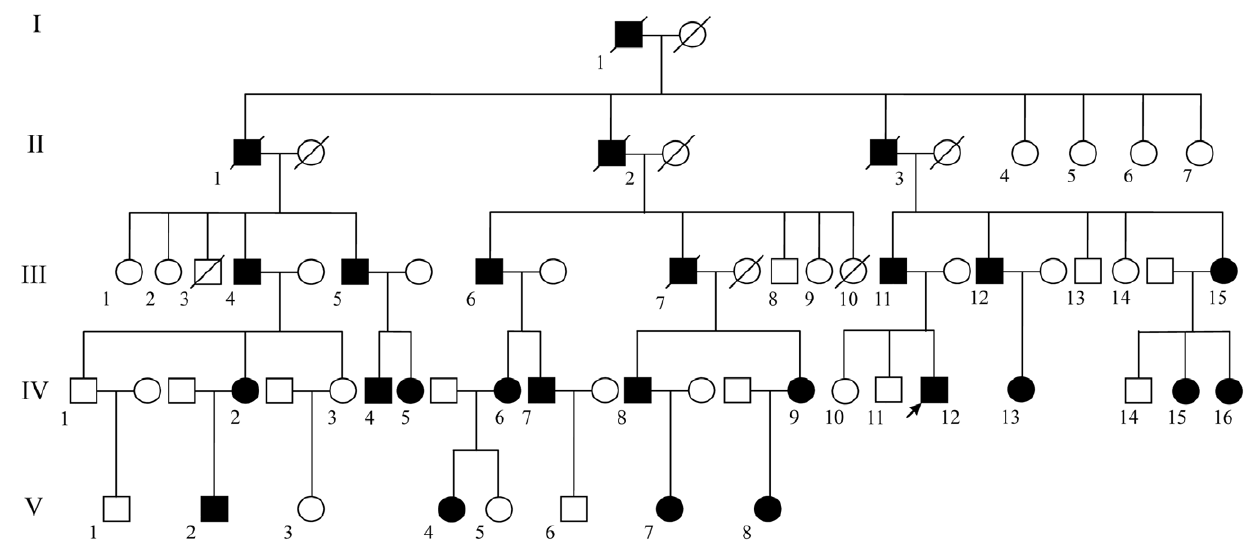
Figure 1. The family tree of the pedigree. The arrow shows the proband IV 12 .